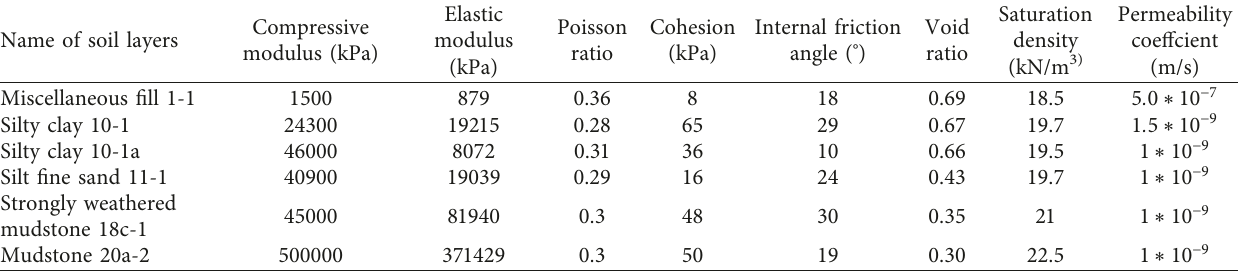
Table 2: Basic parameters of soil mass in the launching-arrival stage of shield tunneling in the XW interval. Name of soil layers